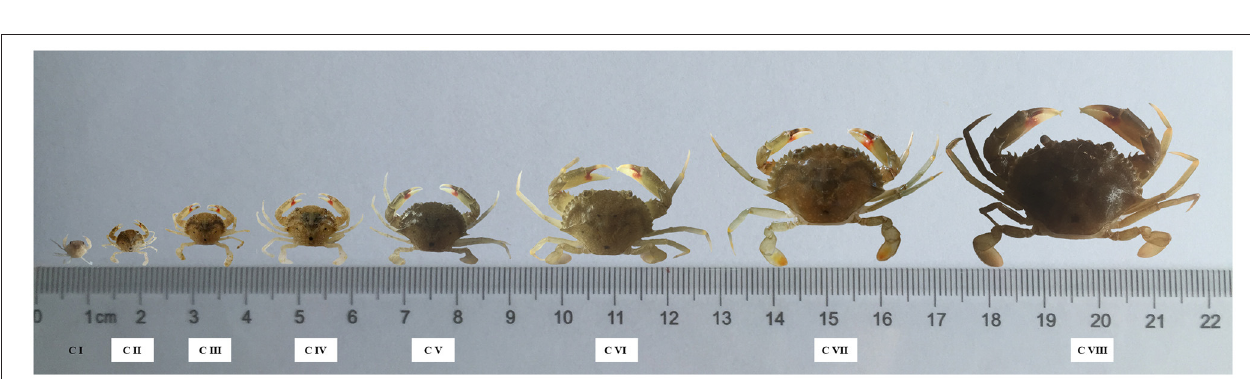
FIGURE 2 | The size of the S. paramamosain at different stages. C I, C II, C III, C IV, C V, C VI, C VII, and C VIII represent crablets of stages I, II, III, IV, V, VI, VII, and VIII.